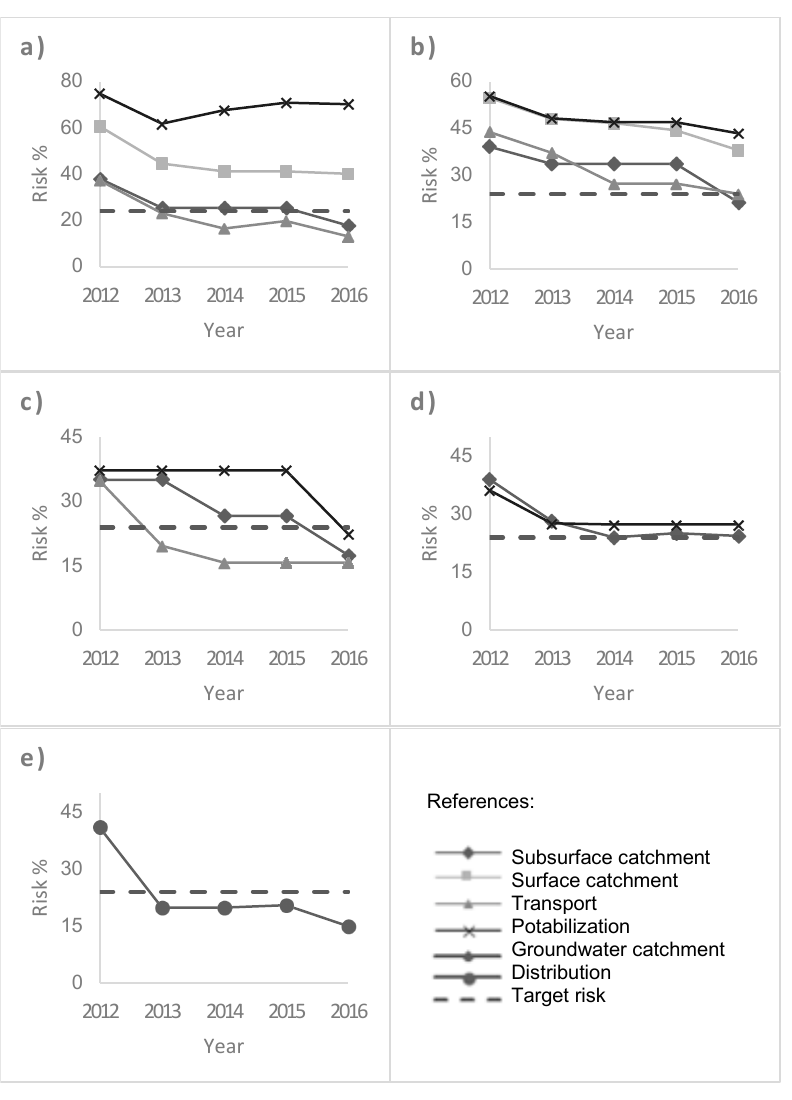
Figure 2. Risks of the individual processes of each system: ( a ) System No. 1; ( b ) System No. 2; ( c ) System No. 3; ( d ) System No. 4; and ( e ) System No. 5. Dotted line: target risk (24%).